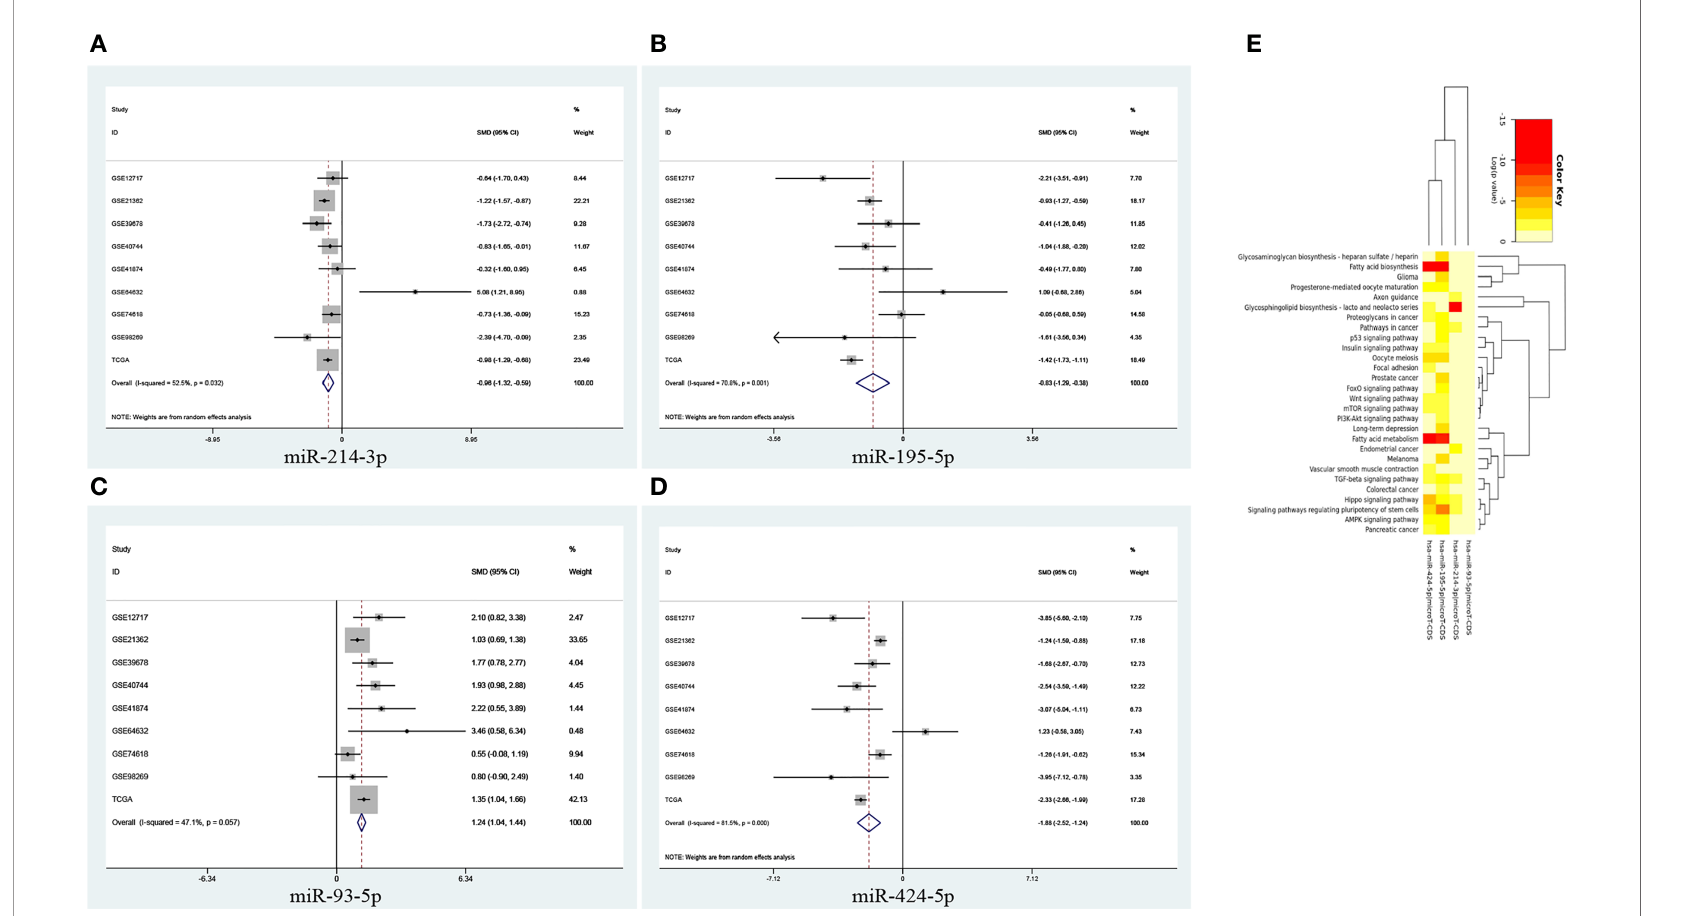
FIGURE 5 | Forest diagrams of datasets assessing the levels of the predicted miRNAs in HCC: (A) miR-214-3p, (B) miR-195-5p, (C) miR-93-5p, (D) miR-424-5p. (E) Heatmap for the signal pathways from DIANA − miRPath in which the four miRNAs are